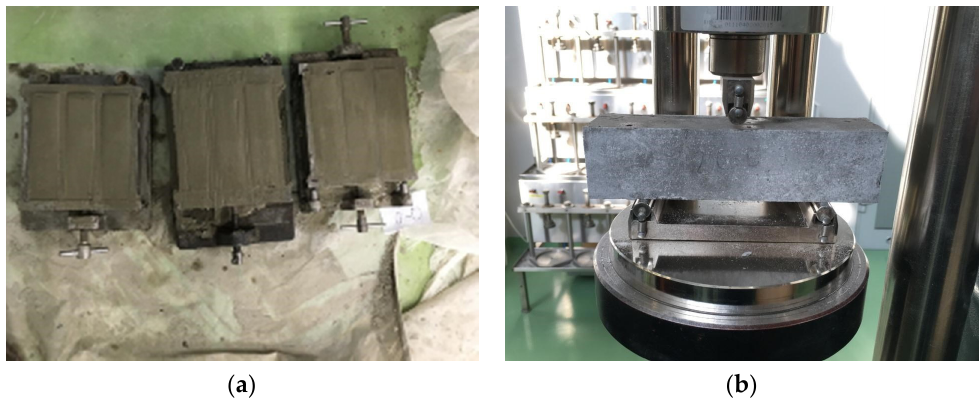
Figure 3. The cement paste samples: ( a ) after being placed in molds; ( b ) during strength tests.